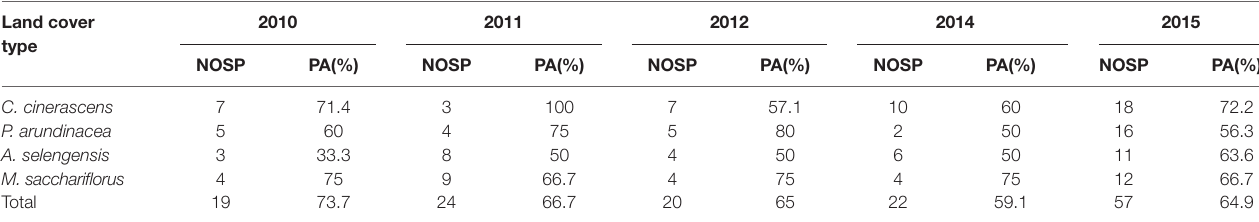
TABLE 3 | Summary of producer’s accuracy for the four dominant vegetation communities of classification results based on field survey data in 2010, 2011, 2012, 2014 and